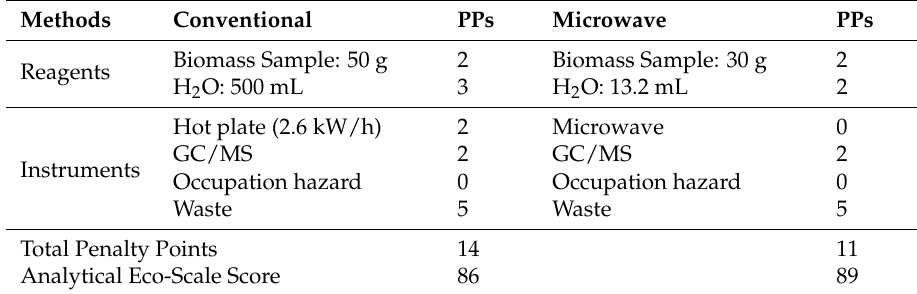
Table 4. Penalty points (PPs) for conventional extraction method versus microwave extraction method analysed by Gas Chromatography Mass Spectrometry (GC/MS).